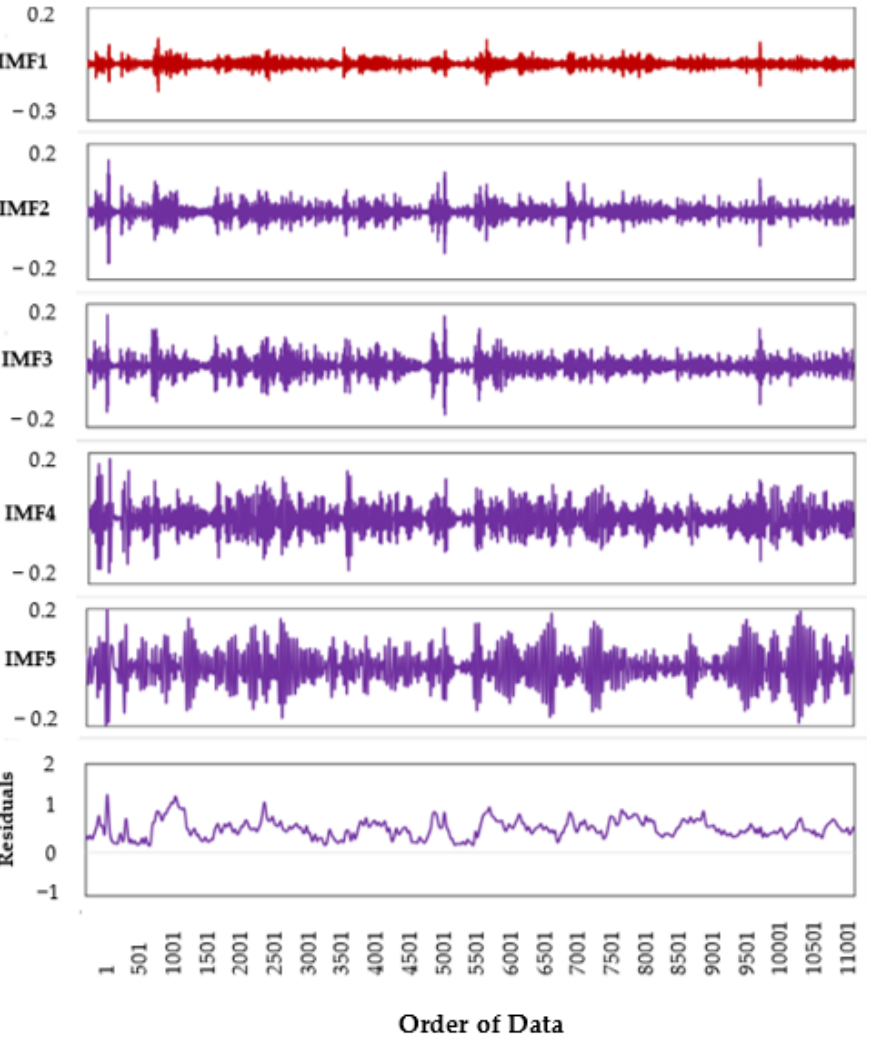
Figure 2. Temporal time-series signal of IMFs and residuals from the EEMD transformation of Hs.